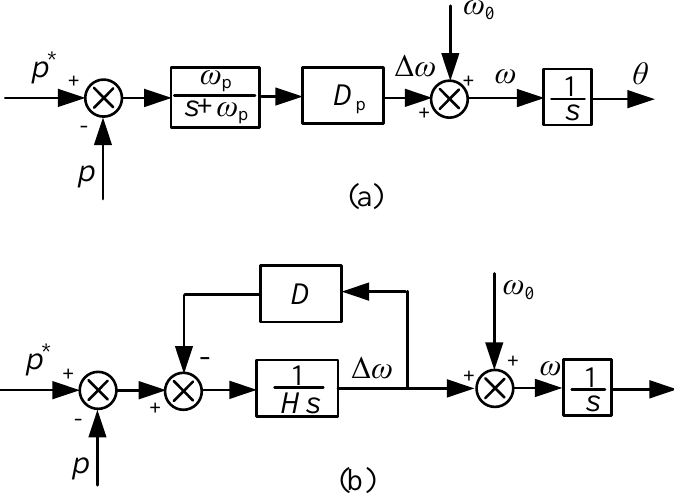
Figure 3. Block diagram of P-f control loops. ( a ), droop control, ( b ), virtual synchronous generator. Two of the common P-f control strategies currently available are illustrated in Figure 3. These are droop-like controls as presented in Figure 3a, and VSG as shown in Figure 3b. Since power synchronous control [8] and droop control are identical in a large-signal sense, this manuscript therefore treats them as the same type of control for the analysis.